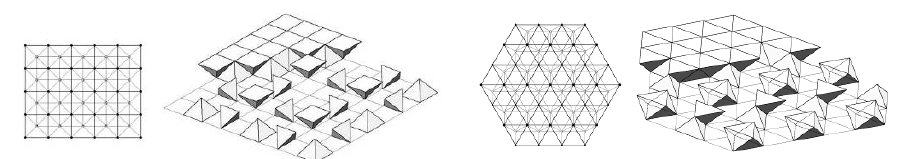
Figure 4: Structure half-octahedron + tetrahedron Figure 5: Structure octahedron + tetrahedron (½O+T)